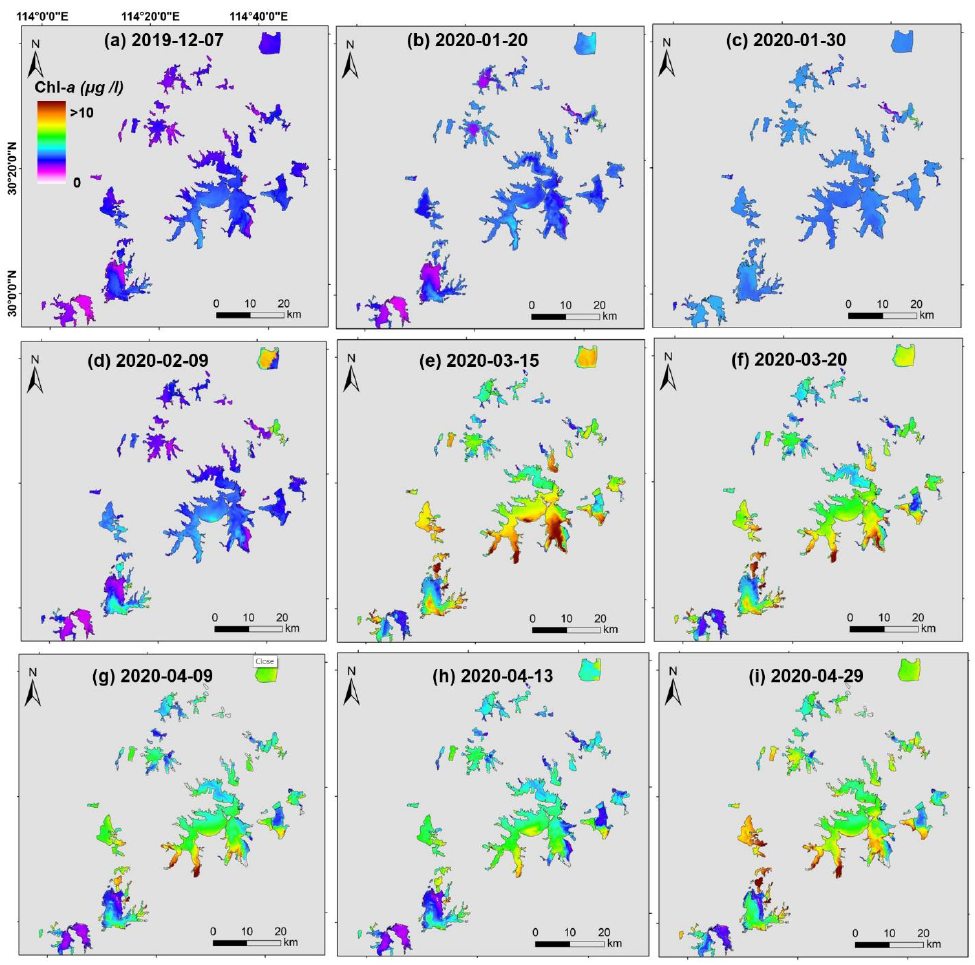
Figure 3. Chlorophyll- a concentration before, during, and post the lockdown period estimated using OC3 algorithm for Wuhan scenic lakes.